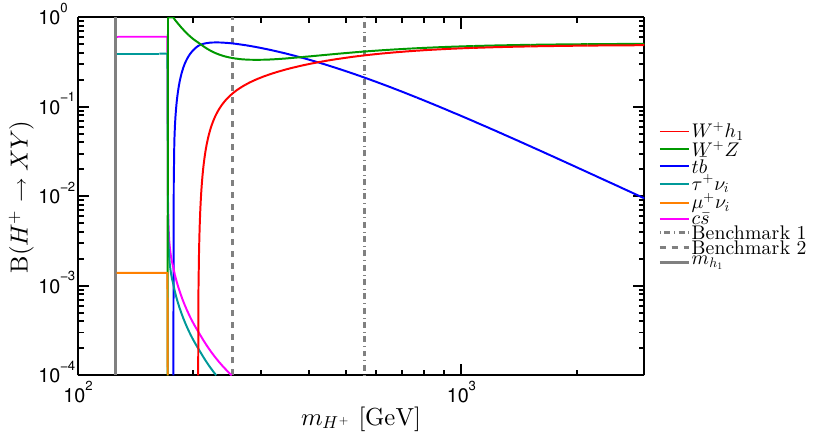
Figure 9 . Branching ratios for H + as a function of its mass. When the channels are open, the main decay modes are H + ! W + Z , H + ! t (cid:22) b , and H + ! W + h 1 .